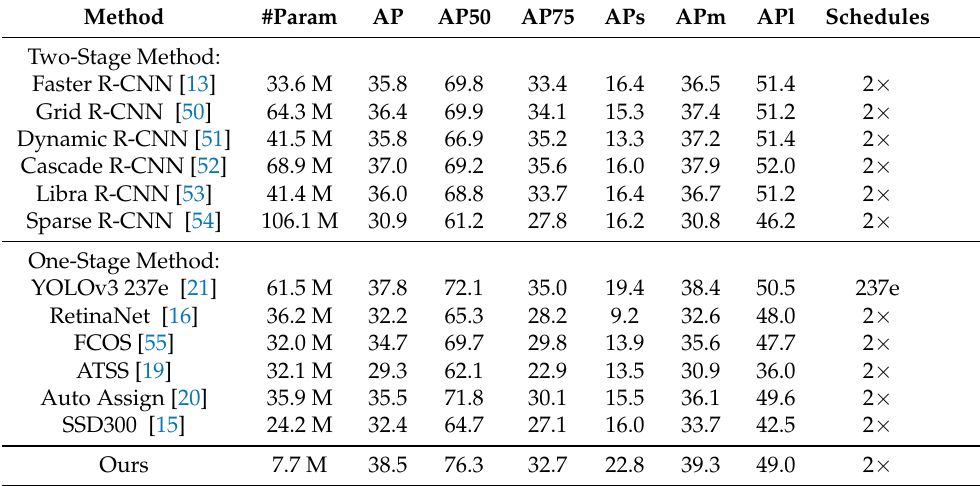
Table 1. Comparison between models on